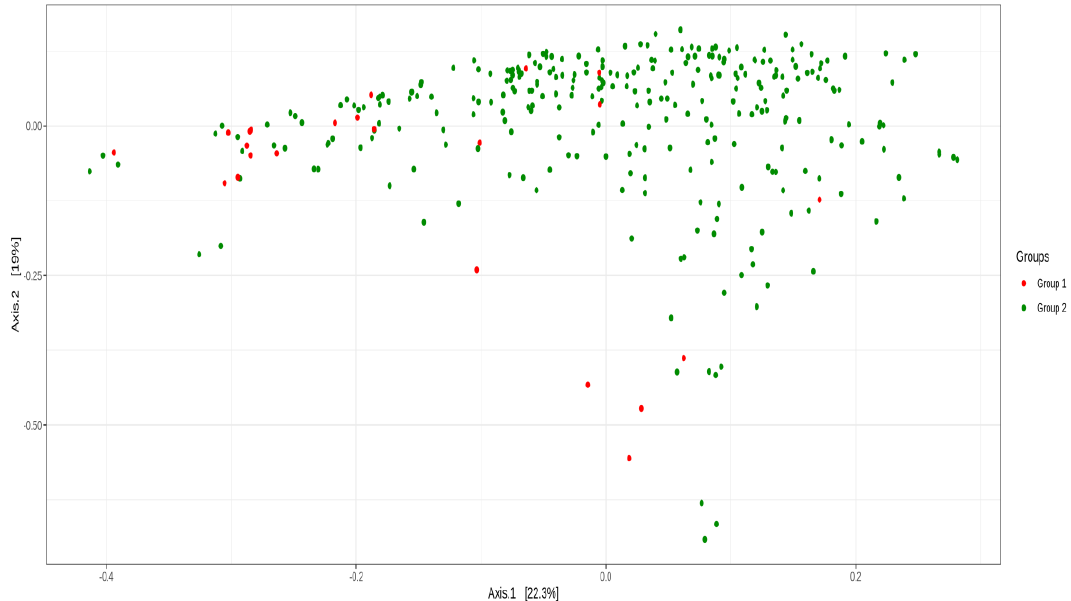
Figure 2. β -diversity analysis of principal coordinate analysis (PCoA) using Unifrac weighted distance between group 1 (BC survivors) and group 2 (healthy controls).